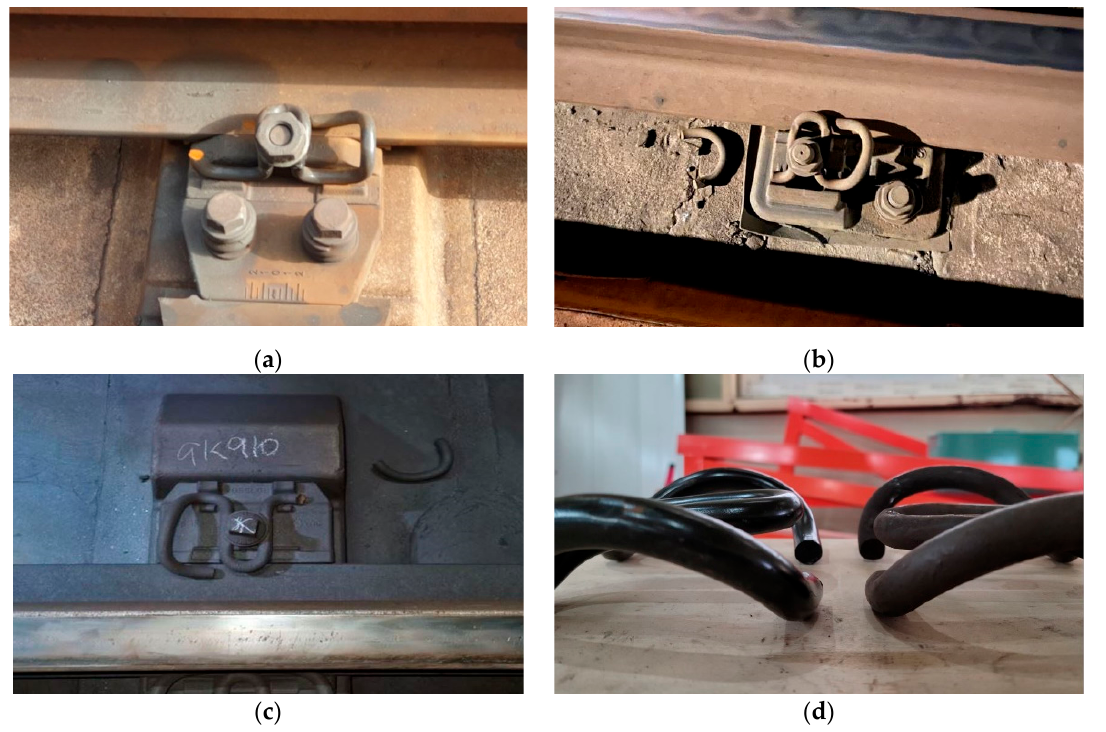
Figure 1. Images of damaged elastic rail fastening systems. ( a ) SKL12; ( b ) SKL14; ( c ) SKL15; ( d ) SKL15 deformation.